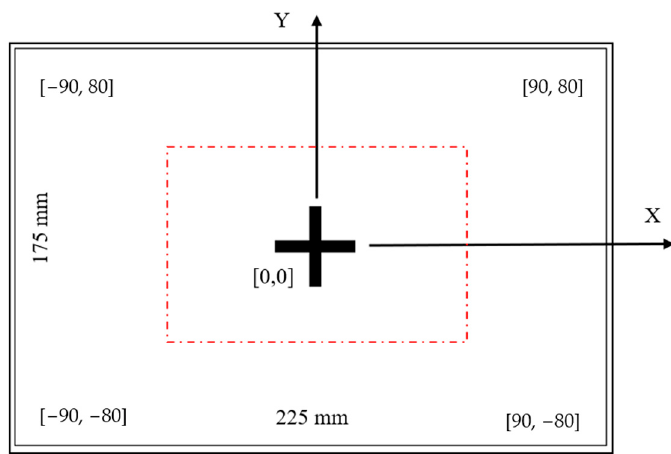
Figure 6. Resistive touch-screen coordinate system.